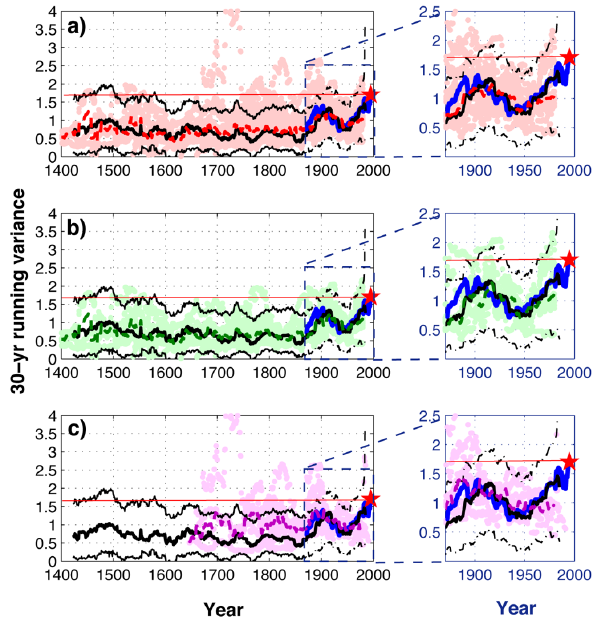
Fig. 9. (a) The running variance (pink dots) of each of the 21 single- station proxies (Table 3) overlaid with their MRV (thick dashed red line). (b) The running variance of the 12 single-station tree ring proxies (light green dots) overlaid with the corresponding MRV (thick green dashed line), while (c) displays the running variance of the 9 single-station coral proxies (light purple dots) overlaid with the corresponding MRV (thick purple dashed line). The thick black line in all three panels represents the MRV of all 14 HPF (10yr cut- off) ENSO reconstructions presented in Fig. 7 and Table 1, while the thin black lines represent the accompanying ENSO reconstruc- tion MRV signal error bars (Appendix A). As in Fig. 7, the blue line represents the MRV of observed ENSO and the red star indicates its most recent value, while the thin red line just extends this most recent value back through time for comparison with the proxy MRV